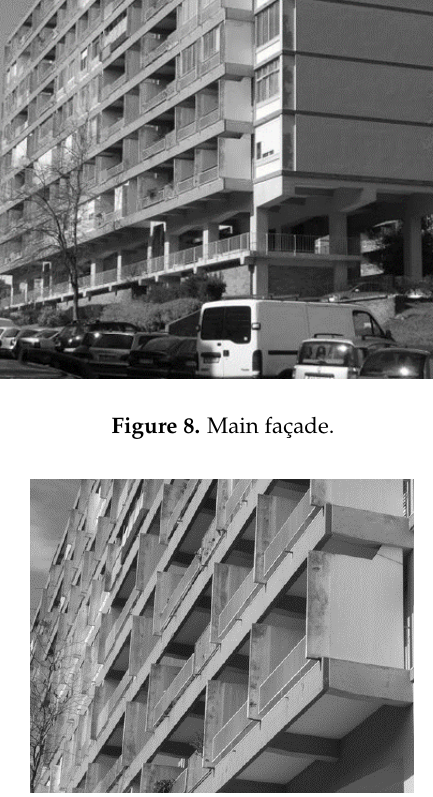
Figure 9. Detail of the principal façade.